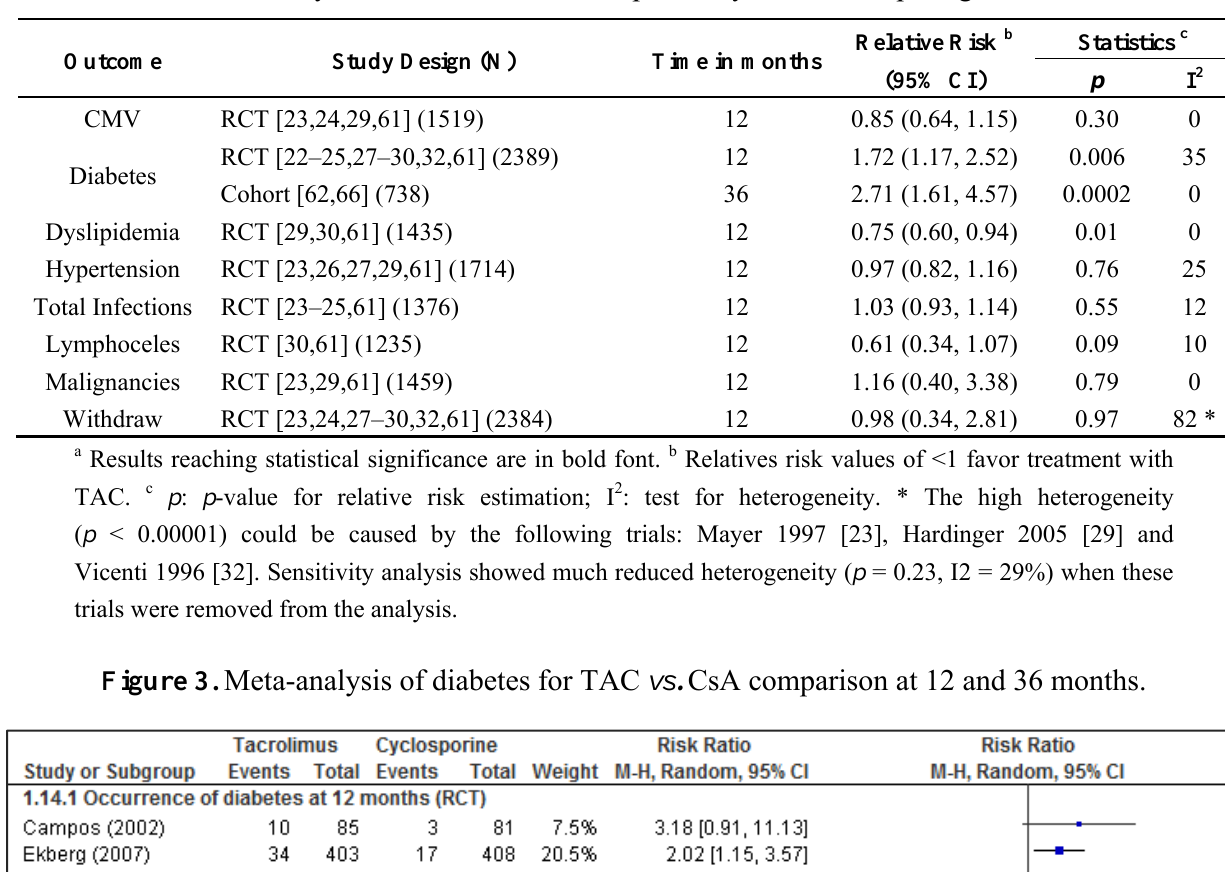
Table 2. Meta-analysis results of outcomes reported by studies comparing TAC vs. CsA a .